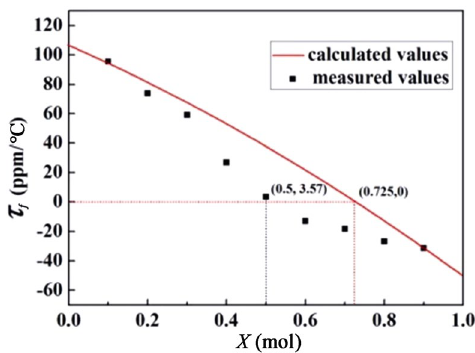
Fig. 9 Temperature coefficients of resonant frequency of (1– x )CoTiNb 2 O 8 – x ZnNb 2 O 6 ceramics sintered at the optimum sintering